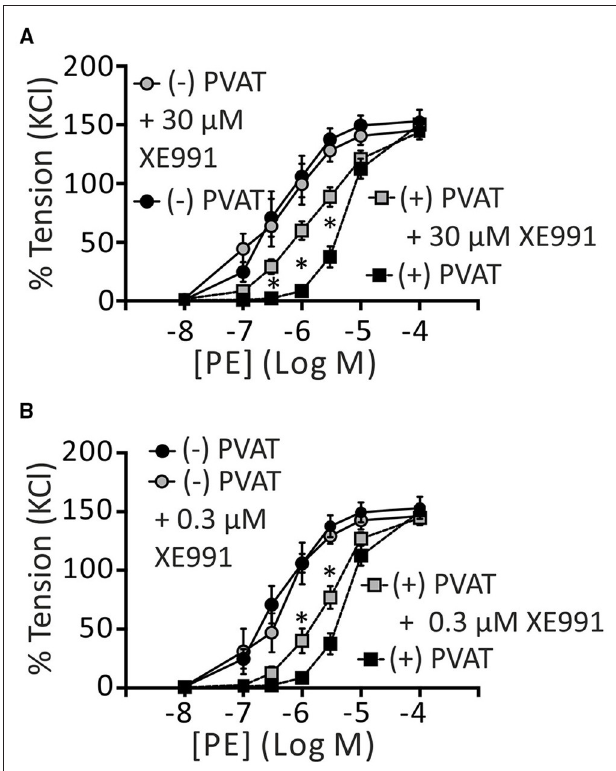
FIGURE 4 | Effects of XE991 on regulation of arterial tone by perivascular adipose tissue. Cumulative concentration-response curves to PE in the presence of 30 µ M XE991 (A) and 0.3 µ M XE991 (B) , expressed as a percentage of KCl contractions. ( − ) PVAT, n = 17; ( + ) PVAT, n = 21. ( + ) PVAT ( + ) 30 µ M XE991, n = 12; ( + ) PVAT + 0.3 µ M XE991, n = 13; ( − ) PVAT ( + ) 30 µ M XE991, n = 5; ( − ) PVAT + 0.3 µ M XE991, n = 5. * p < 0.05, repeated-measures two-way ANOVA, followed by Bonferroni post hoc test * in (A) , ( + ) PVAT vs. ( + ) PVAT + 30 µ M XE991. *In (B) , ( + ) PVAT vs. ( + ) PVAT + 0.3 µ M XE991. Experiments were performed on mouse mesenteric